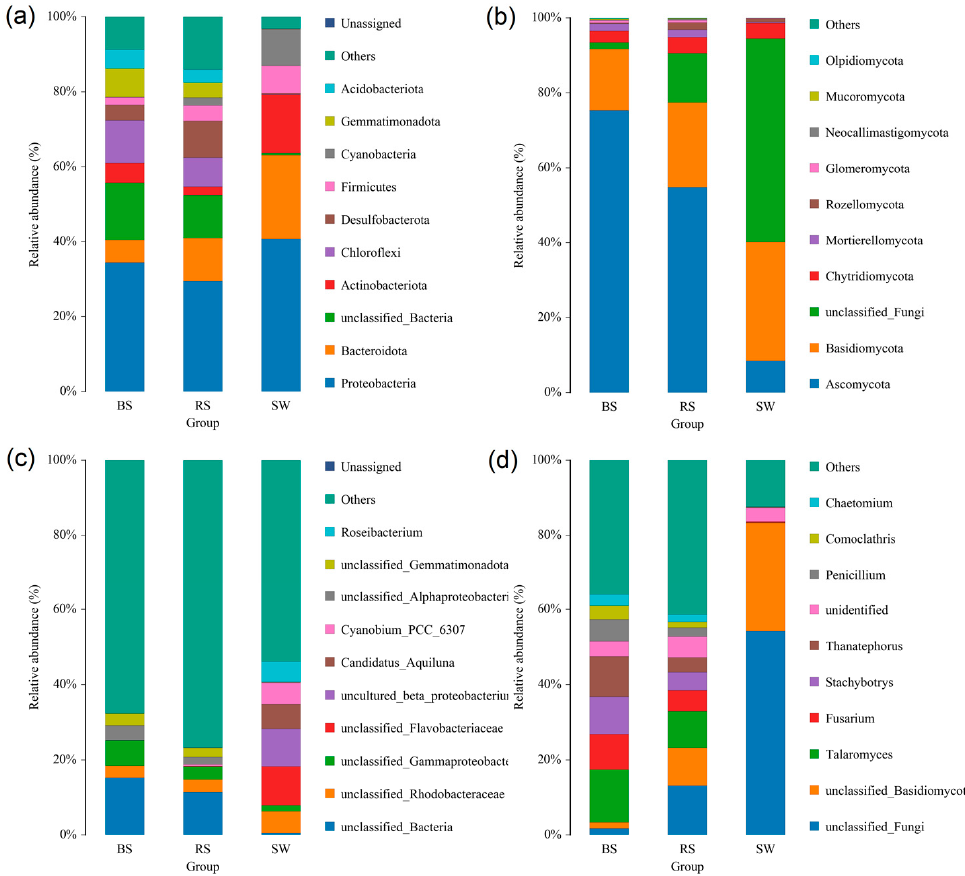
Figure 6. Relative abundance of bacterial ( a , c ) and fungal ( b , d ) communities at the phylum ( a , b ) and genus ( c , d ) level. RS: the seagrass rhizosphere soil samples; BS: sediment samples; SW: seawater samples .